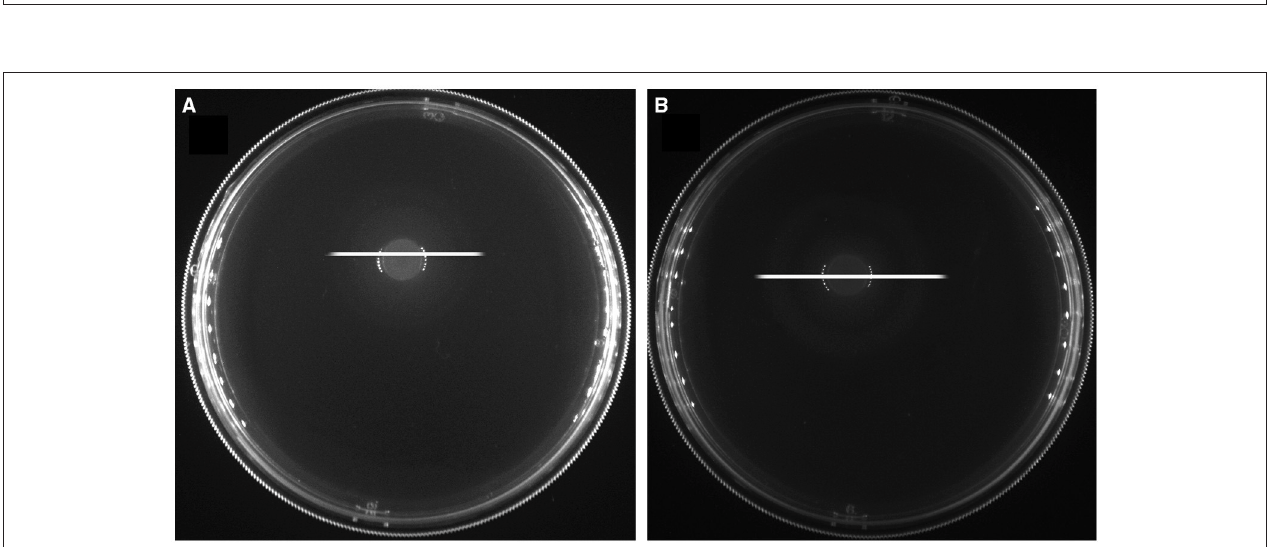
FIGURE 5 | Chemotaxis of the mutant and wild-type strain. The zones of accumulation (chemoattractant) of C. jejuni 1 cj0371 and C. jejuni 11168 after 6h of incubation at 42 ◦ C. The plug contains 0.1M DL-malic acid and the length of white lines are C. jejuni 11168 (A) and C. jejuni 1 cj0371 (B) diameters of chemotaxis